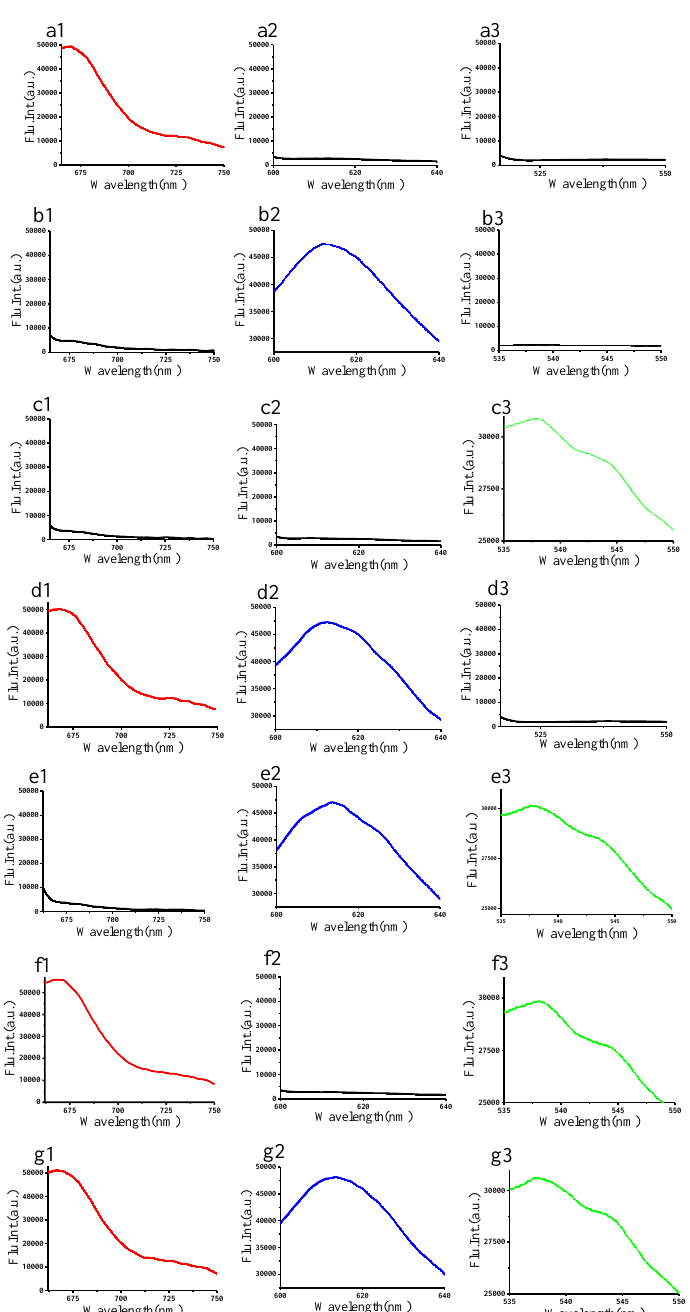
Figure 2. The mRNA biosensor was mixed with solutions consisting of different combinations of the three targets. ( a1 – a3 ) Target mRNA: AlinOBP14-T1. The excitation wavelengths were 643 nm ( a1 ), 575 nm ( a2 ), and 494 nm ( a3 ), respectively. ( b1 – b3 ) Target mRNA: AlinOBP14-T2. The exci- tation wavelengths were 643 nm ( b1 ), 575 nm ( b2 ), and 494 nm, ( b3 ), separately. ( c1 – c3 ) Target mRNA: AlinOBP14-T3. The excitation wavelengths were 643 nm ( c1 ), 575 nm ( c2 ), and 494 nm ( c3 ), respectively. ( d1 – d3 ) Target mRNA: AlinOBP14-T1 and AlinOBP14-T2. The excitation wavelengths were 643 nm ( d1 ), 575 nm ( d2 ), and 494 nm ( d3 ), separately. ( e1 – e3 ) Target mRNA: AlinOBP14-T2 and AlinOBP14-T3. The excitation wavelengths were 643 nm ( e1 ), 575 nm ( e2 ), and 494 nm ( e3 ), respectively. ( f1 – f3 ) Target mRNA: AlinOBP14-T1 and AlinOBP14-T3. The excitation wavelengths were 643 nm ( f1 ), 575 nm ( f2 ), and 494 nm ( f3 ), separately. ( g1 – g3 ) Target mRNA: AlinOBP14-T1, AlinOBP14-T2 and AlinOBP14-T3. The excitation wavelengths were 643 nm ( g1 ), 575 nm ( g2 ), and 494 nm ( g3 ),